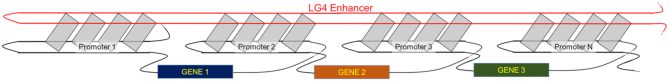
LG4 enhancer model. Potential mechanism by which LG4s could interact with multiple gene promoters to coordinate their expressions.